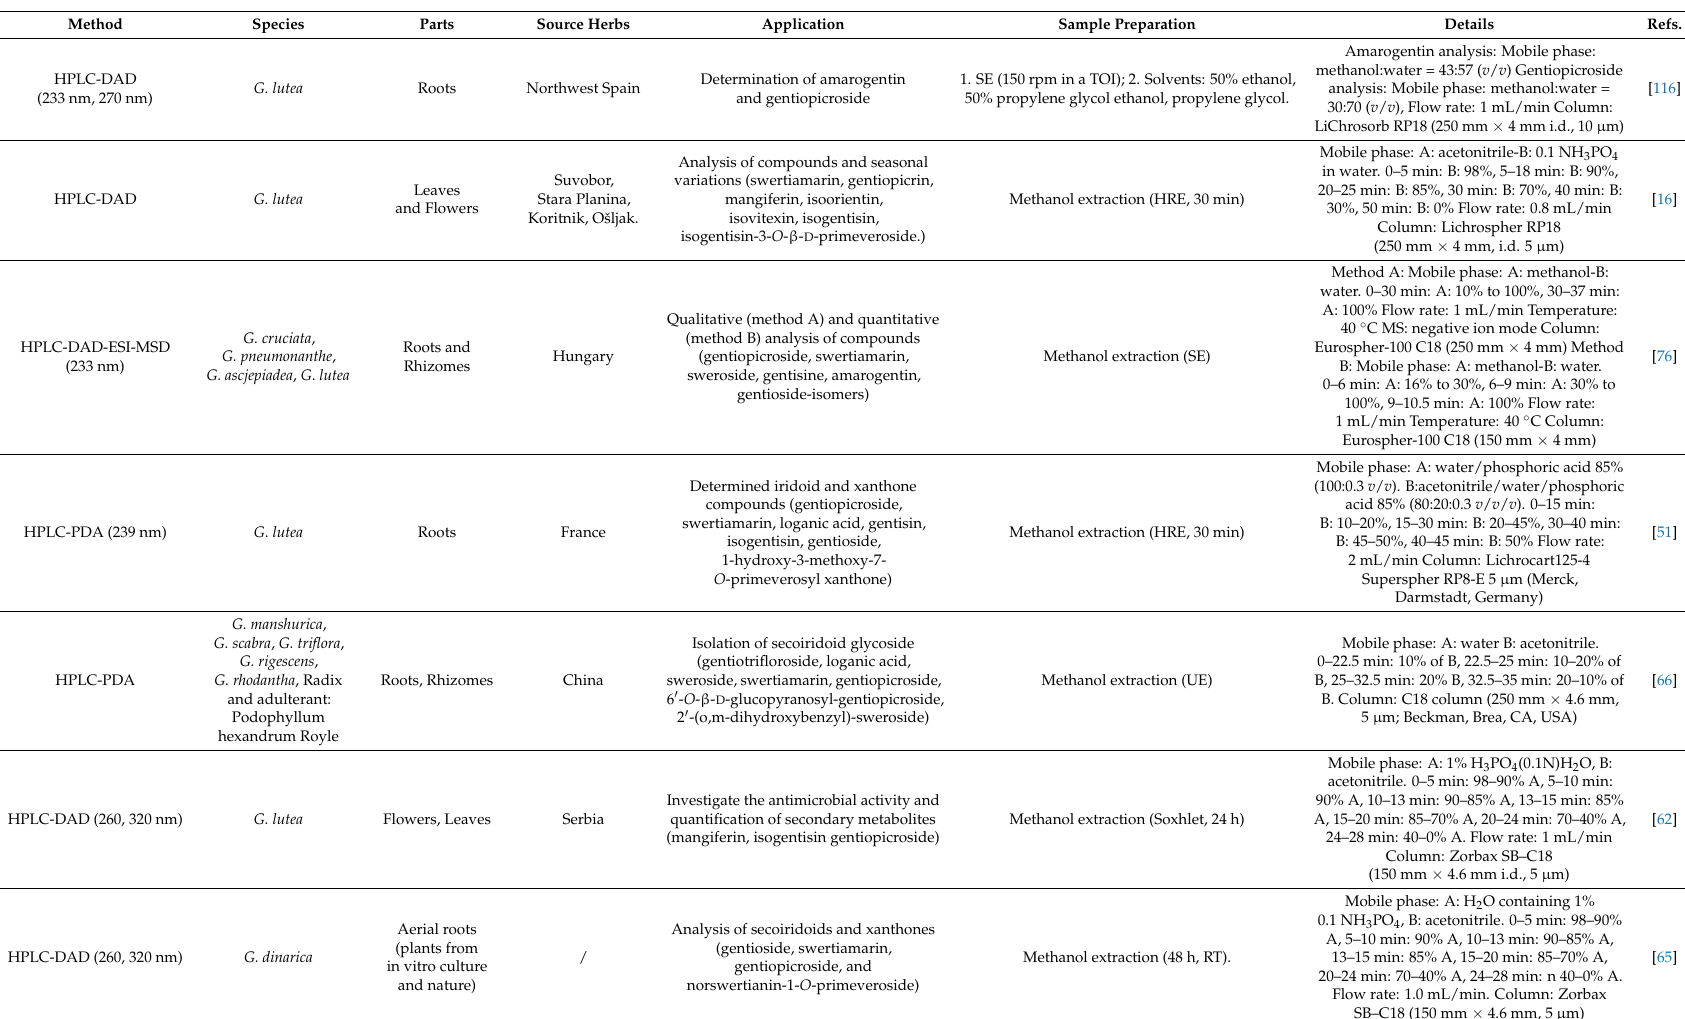
Table 4. Cont. Sample Preparation Details